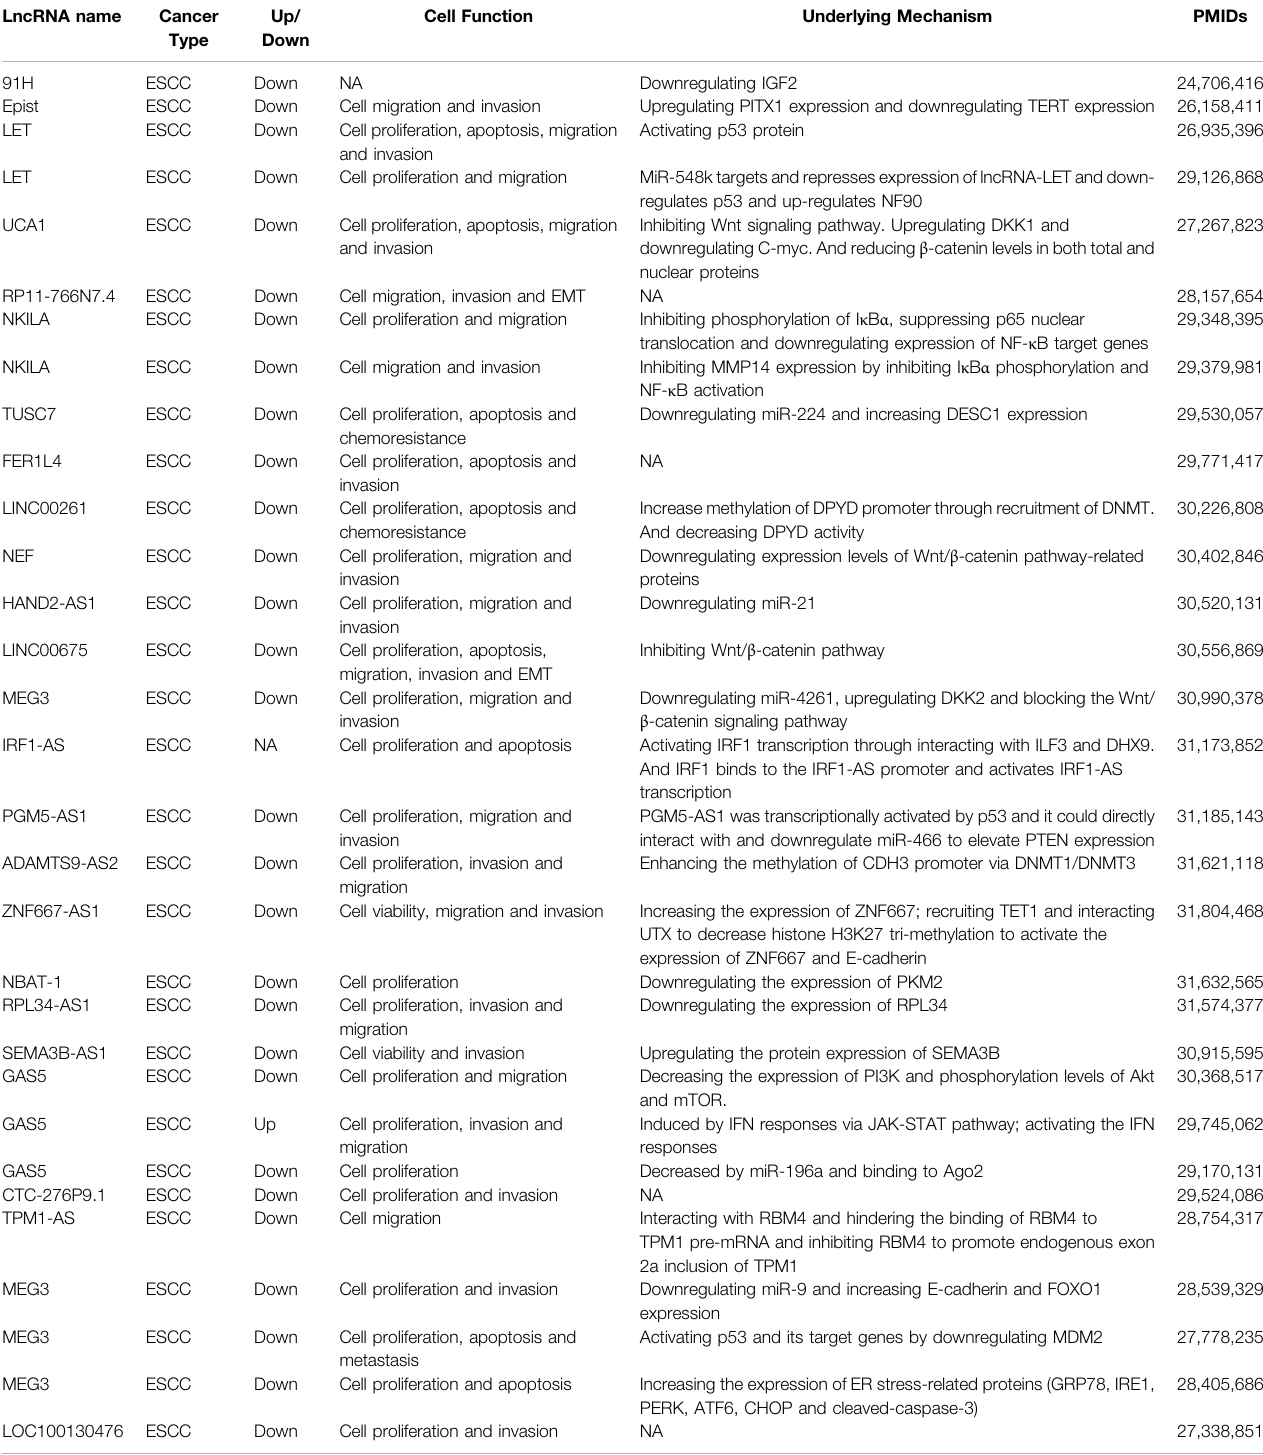
TABLE 2 | EC-associated tumor suppressive